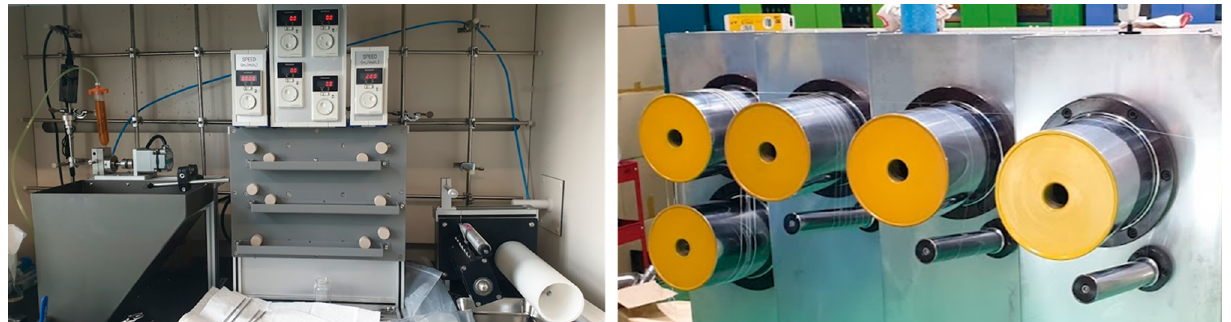
Figure 1. Schematic of the process of wet-spun PAN fiber.